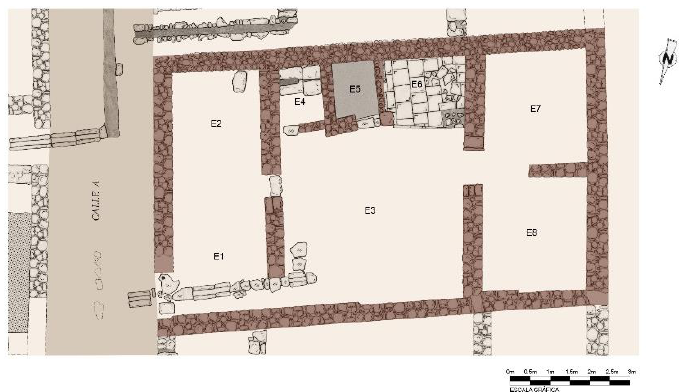
Figure 20. Variant 4. House 12. Plan and room distribution.